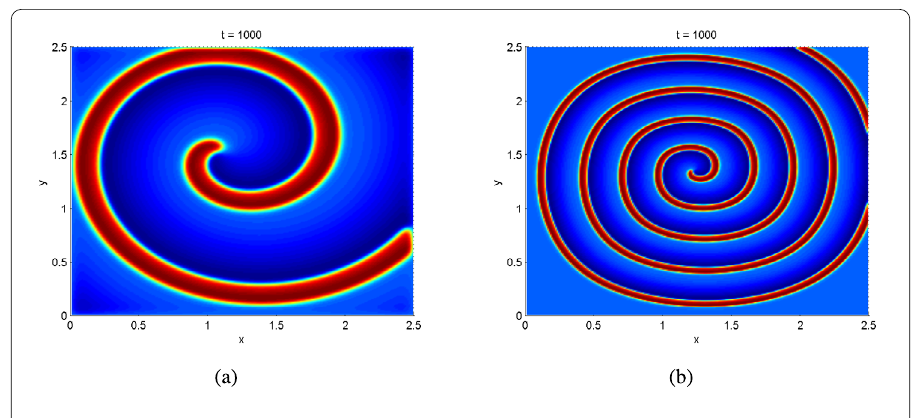
Figure 1 Solutions of Example 2 with α x = α y = 2 for varying diffusion coefficient: ( a ) K x = K y = 1 E – 4 and ( b ) K